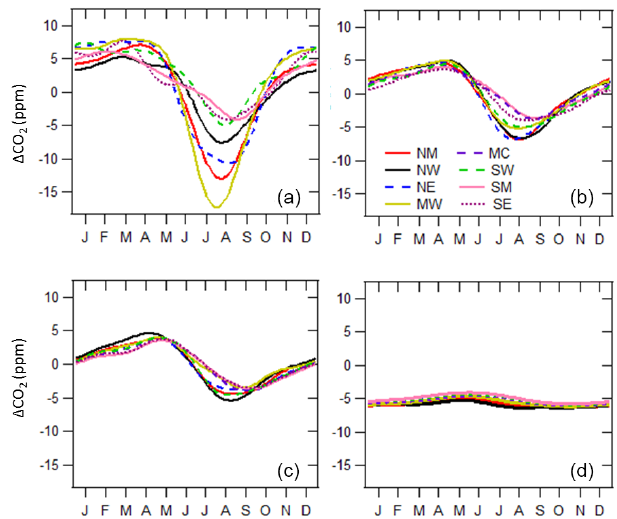
Figure 4. Multi-year (2004–2014) average smooth seasonal curves of CO 2 relative to the long-term deseasonalized trend at Mauna Loa for different vertical layers: (a) aircraft and tower data under 2km – MC is not presented because only limited data were available due to high surface elevations ( > 1.5km on average) in this region; (b) aircraft data from 2 to 5km; (c) aircraft data from 5 to 8.5km; (d) CT2015 model results for layers above 330hPa ( ∼ 8.5km) to 0hPa ( ∼